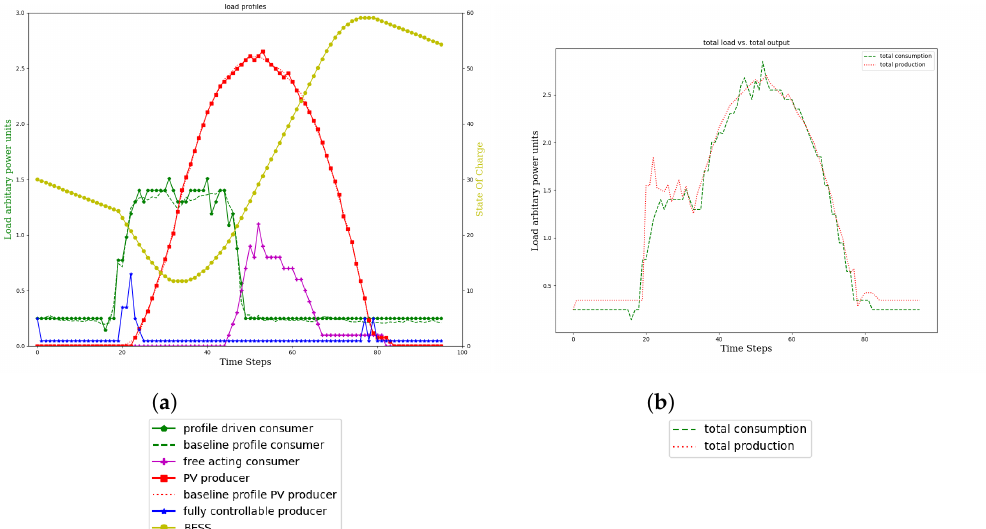
Figure 8. Evaluation on day 2, with agents trained on day 2. ( a ) Agent load curves and profiles. ( b ) Load